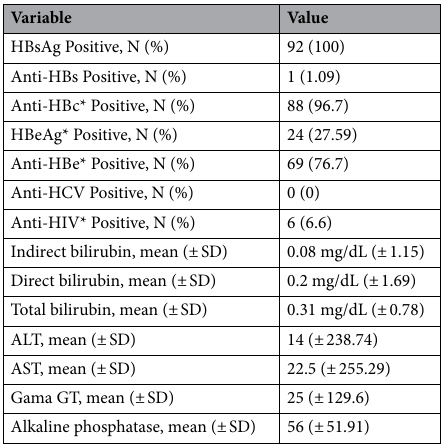
Table 1. Biochemical, HBV, HCV and HIV serological markers among HBV infected individuals (n = 92). SD standard deviation. *Totals are not from 92 subjects due to missing